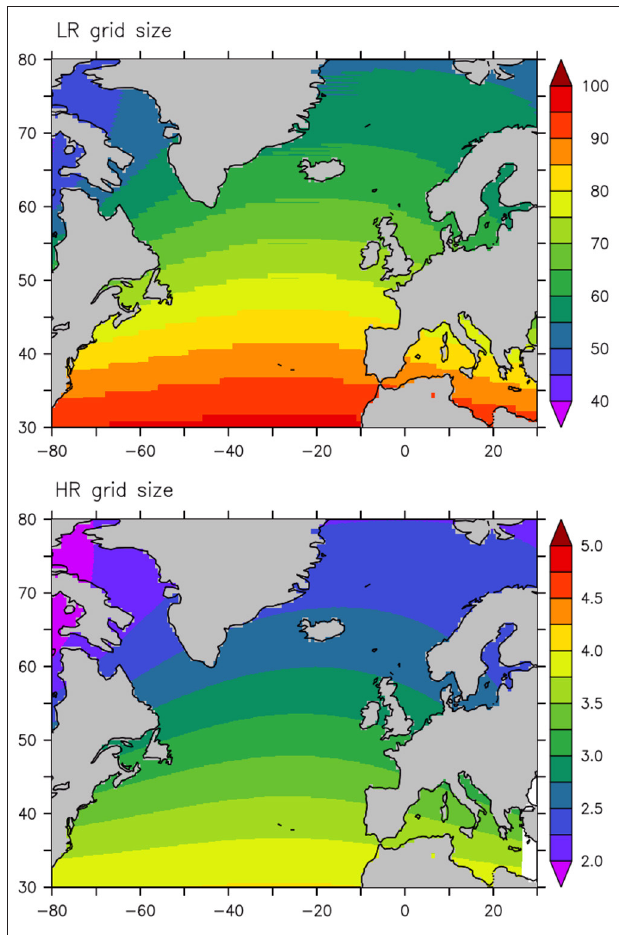
FIGURE 1 | Resolution of the grid (in meters) represented as the square root of the length scale of the latitudinal grid size multiplied by the longitudinal grid size. On top is represented the resolution in the ocean of the low resolution (LR) coupled model, while on the bottom is shown the resolution of the high resolution (HR) regional ocean